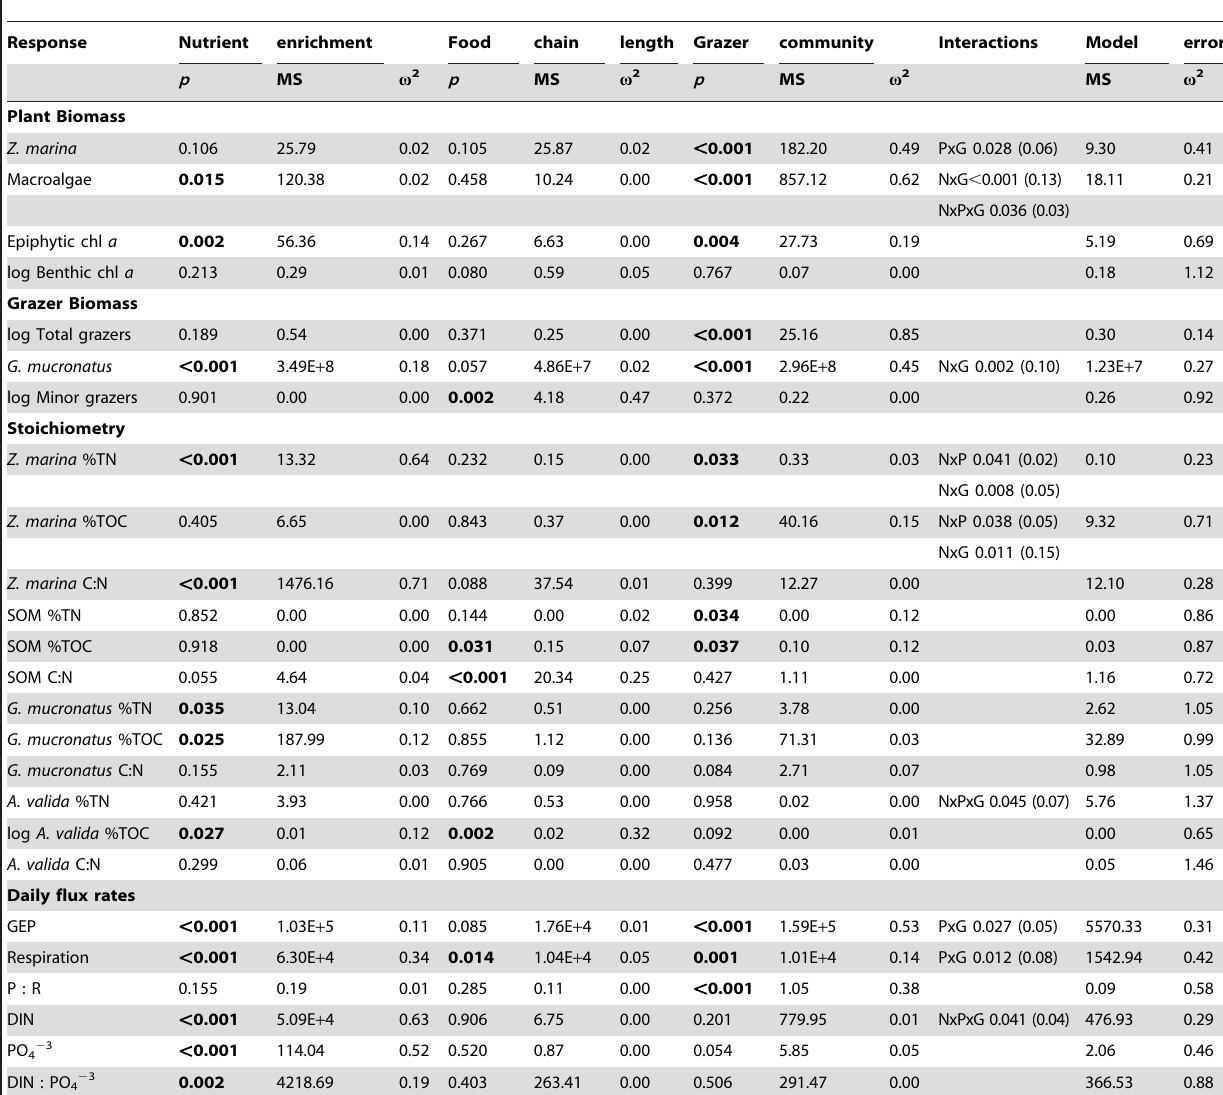
Table 1. Tests of significance and estimated magnitudes of effects ( v 2 ) of nutrient enrichment, food chain length, and grazer species richness and their interactive effects on biomass, elemental ratios, and daily flux